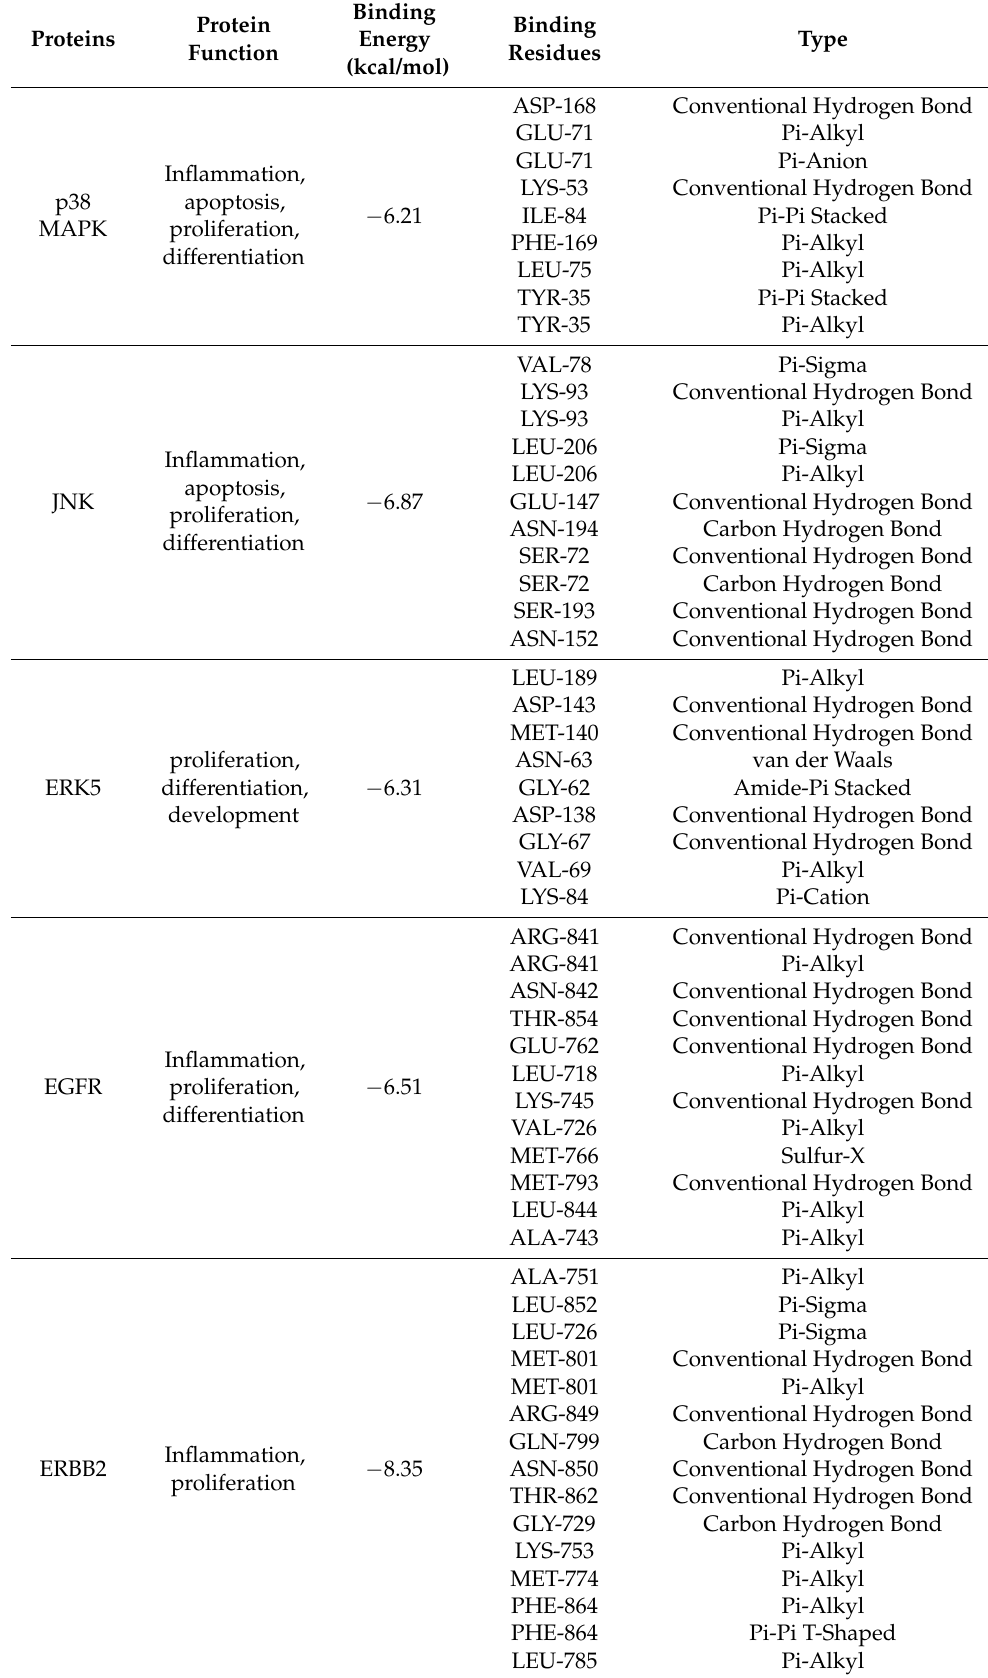
Table 2. Intermolecular interactions between Fr11 and p38 MAPK, JNK, ERK5, EGFR, and ERBB2. Binding Protein Energy Proteins Function